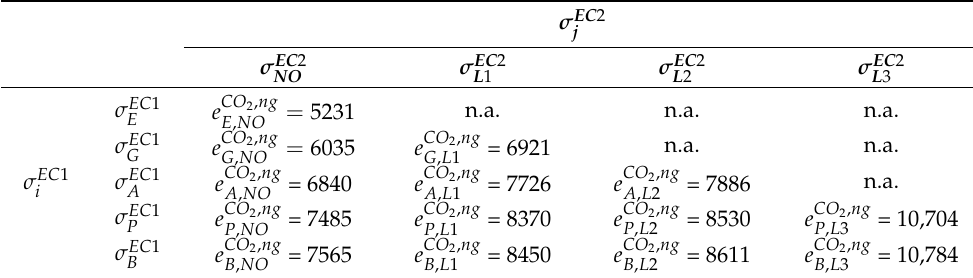
Table 4. Computational results of virtual CO 2 emission in kg within one cycle of the time-window of analysis.